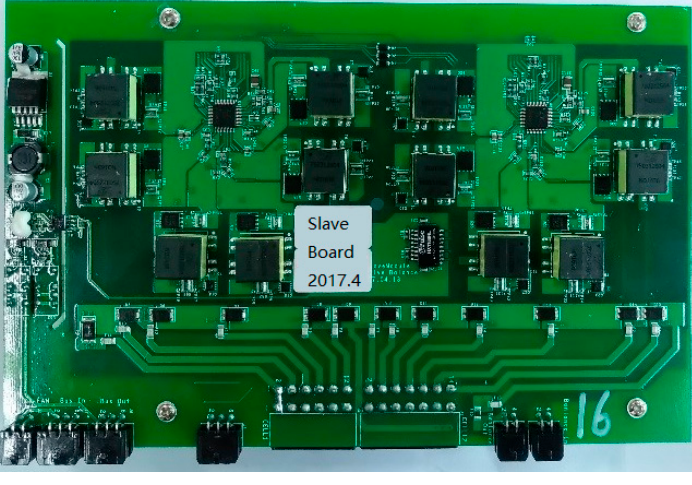
Figure 12. Slave controller. Figure 12. Slave